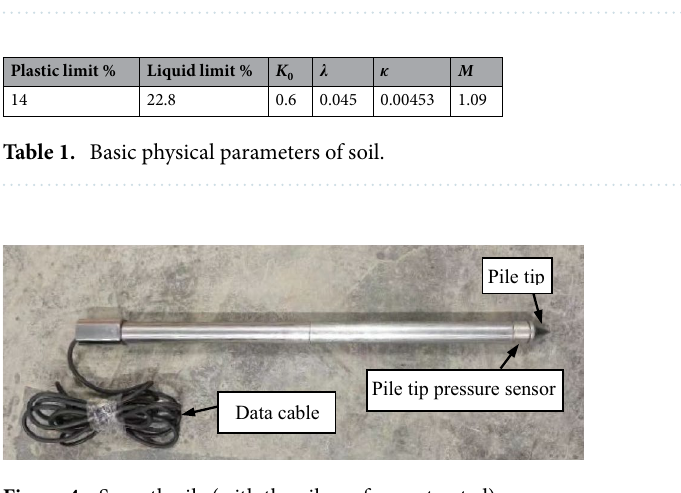
Figure 3. Grain-size distribution curve of testing soil.